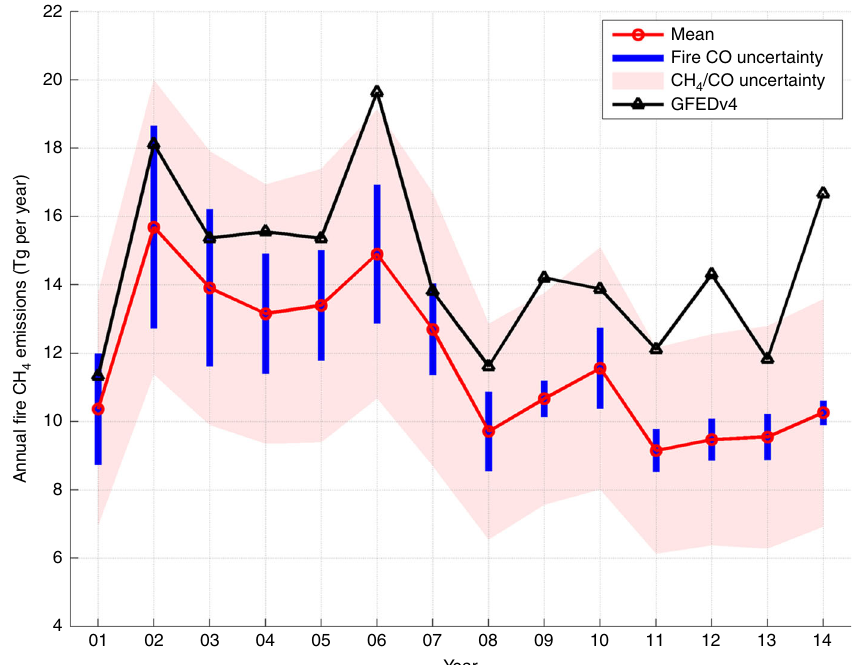
Fig. 1 Trend of methane emissions from biomass burning. Expected methane emissions from fi res based on the Global Fire Emissions Database (black) and the CO emissions plus CH 4 /CO ratios shown here (red). The range of uncertainties in blue is due to the calculated errors from the CO emissions estimate and the shaded red describes the range of error from uncertainties in the CH 4 /CO emission